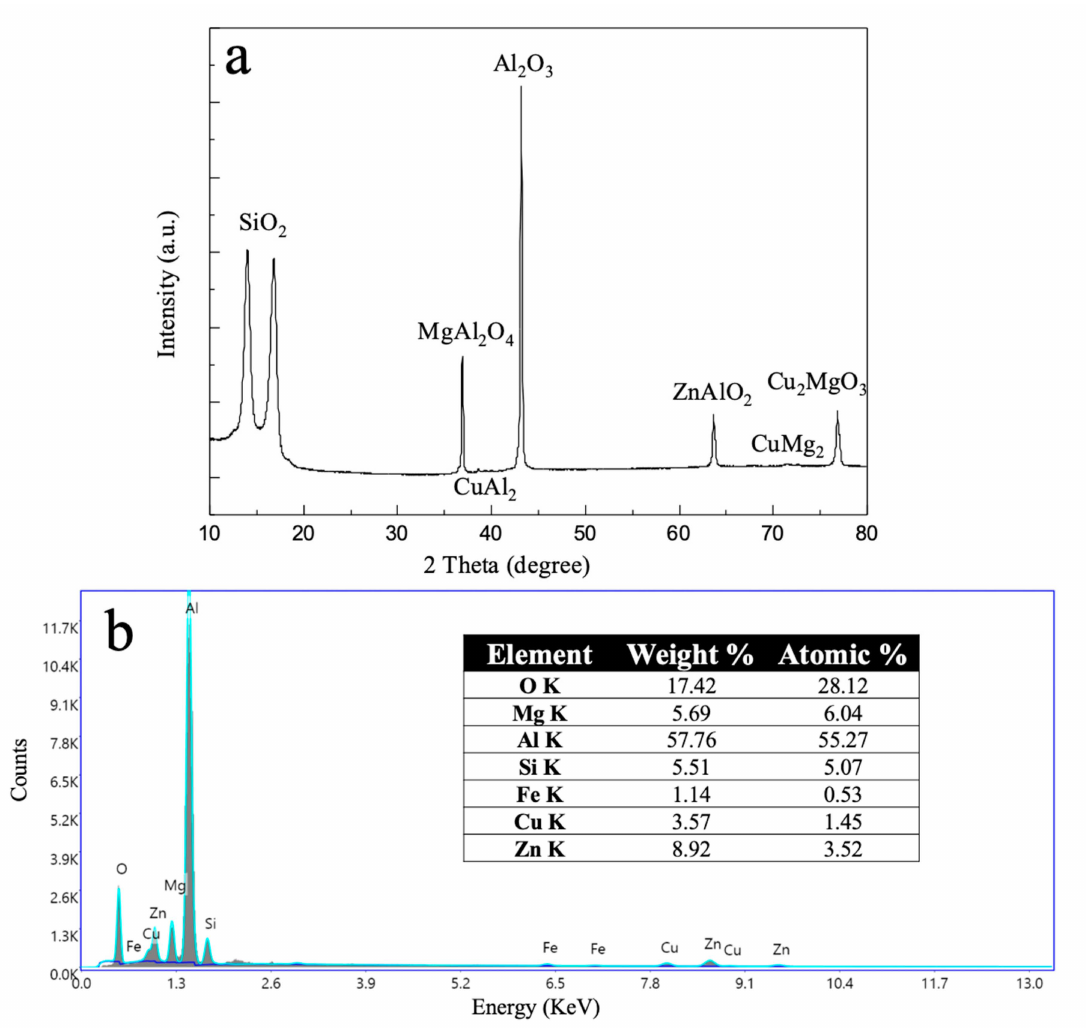
Figure 7. XRD pattern ( a ) and EDS characterization ( b ) of 7075 aluminum alloy after